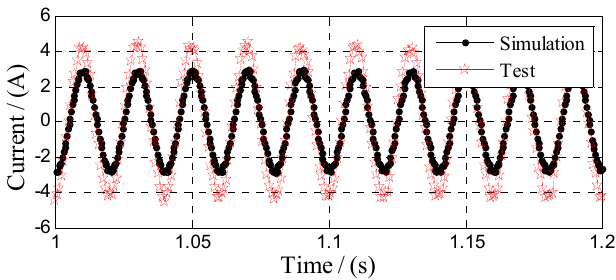
Figure 16. Comparison of simulation and experimental currents under the healthy motor condition.